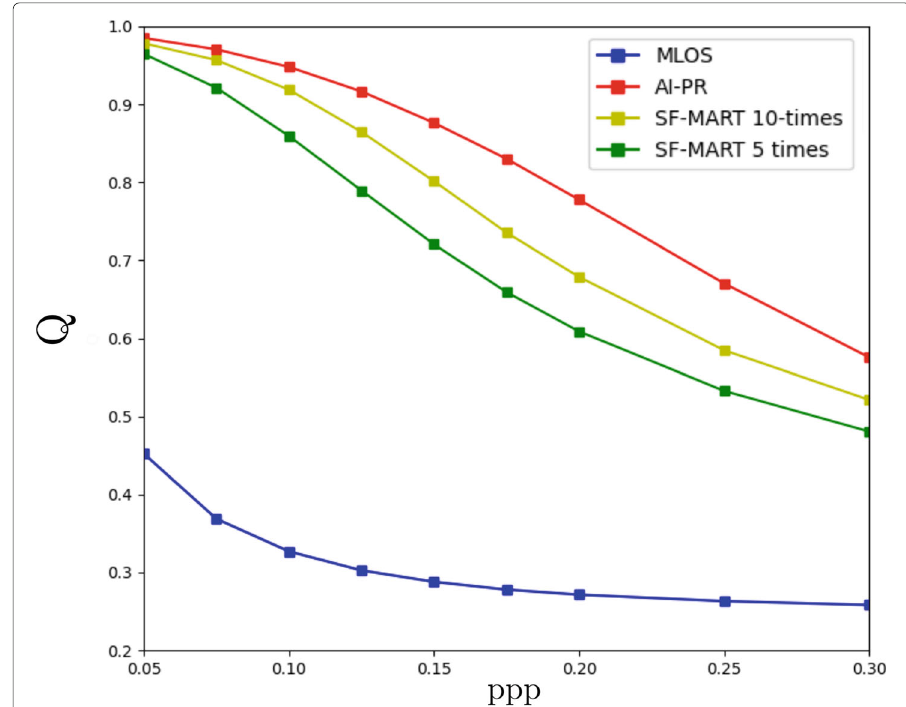
Fig. 5 Quality factor Q of different methods with varying seeding density from 0.05 to 0.3